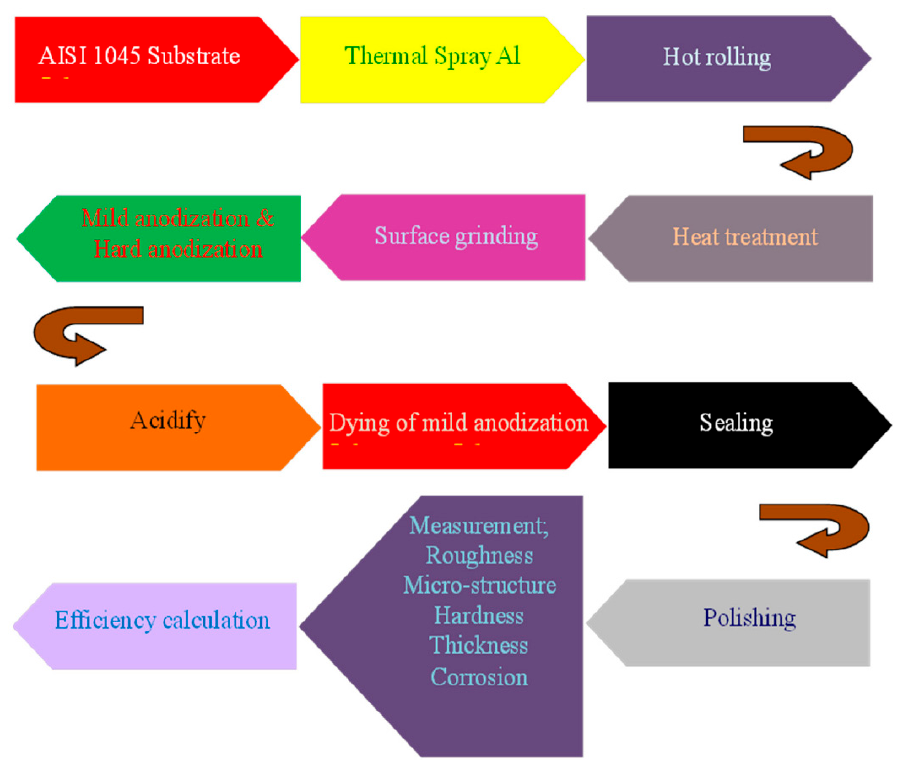
Figure 10. Flowchart outlining each step of the research. Reprinted with permission from [10]. Cop-